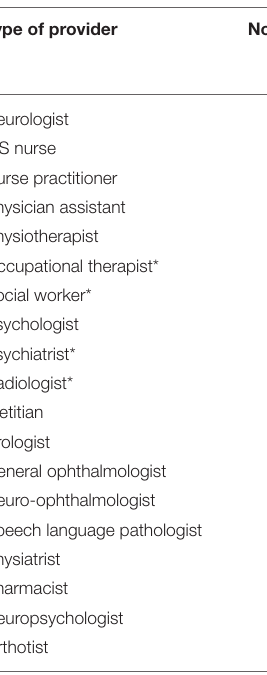
TABLE 2 | Availability of health care providers to multiple sclerosis (MS)